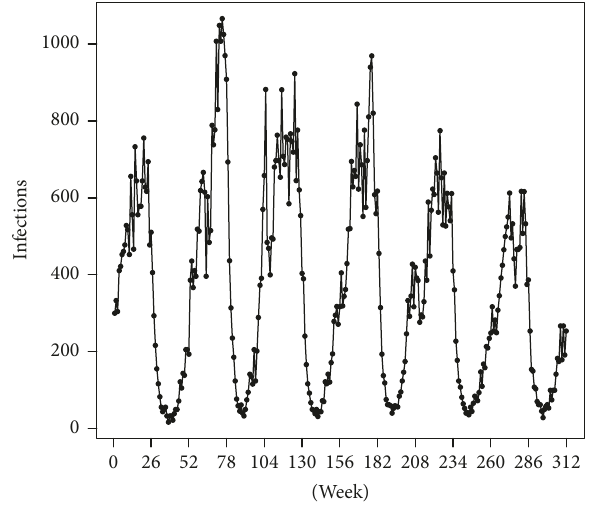
Figure 3: Weekly number of reported infections of chickenpox in the Valencian Community from 2007 to